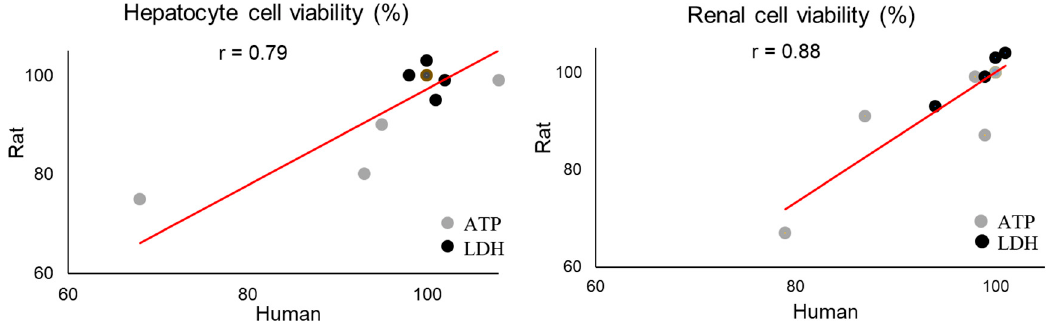
Figure 3. Pearson’s correlation (r) between rat and human adenosine triphosphate (ATP) and lactate dehydrogenase (LDH) in hepatocytes and renal cells after thioacetamide-S-oxide exposure in vitro .